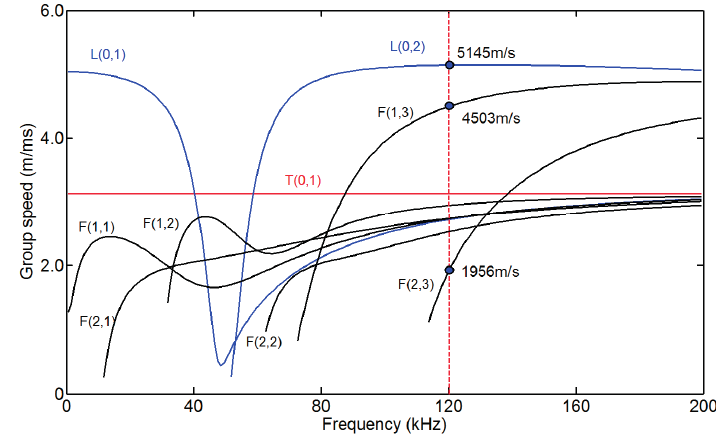
Figure 3. Group speed dispersion curves of the pipe with a 38-mm outside diameter and 5-mm wall thickness.